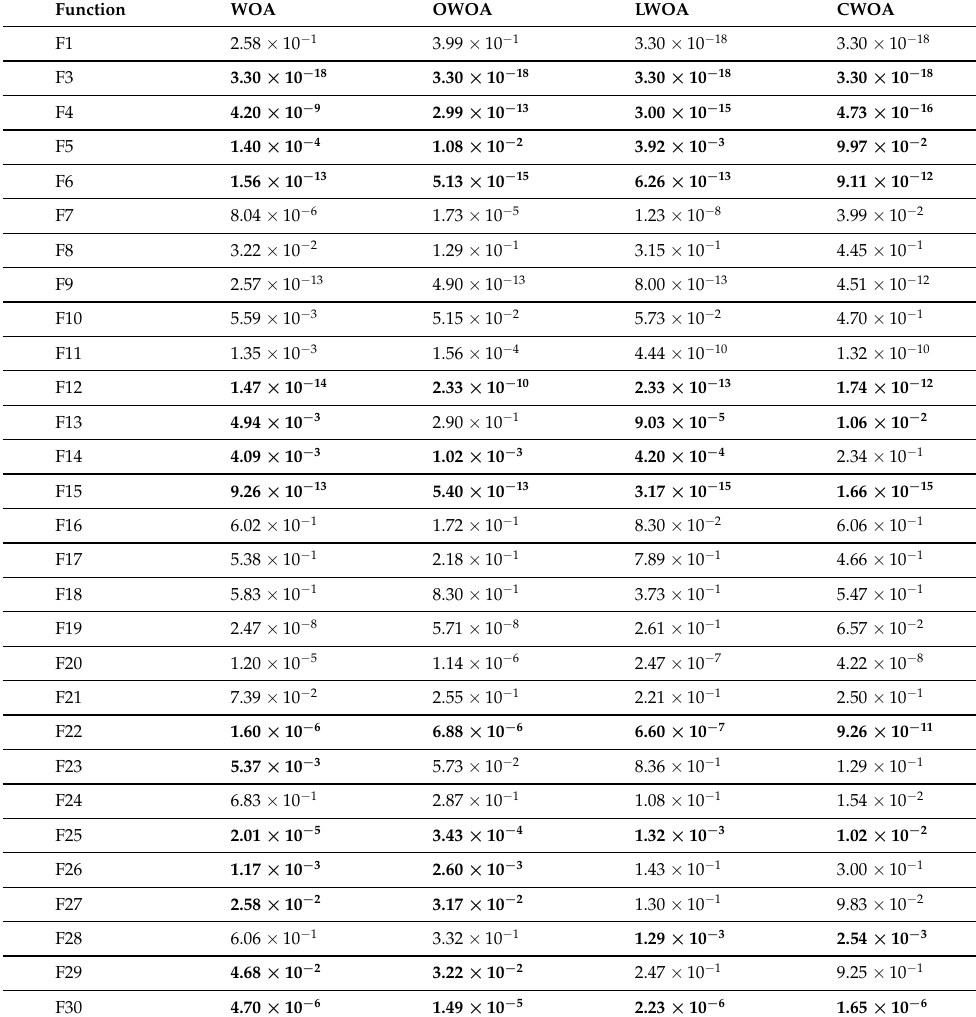
Table 7. Results of the rank sum test on Benchmark Suite-2